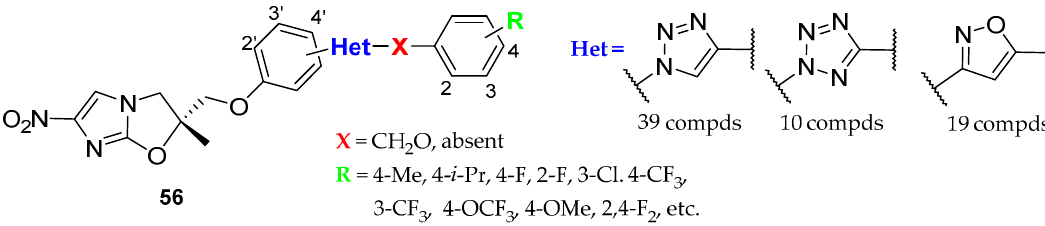
Figure 14. Delamanid analogues ( 56 ) with central piperidinyl replaced by heteroaryl moieties. Molecules 2020 , 25 , x FOR PEER REVIEW